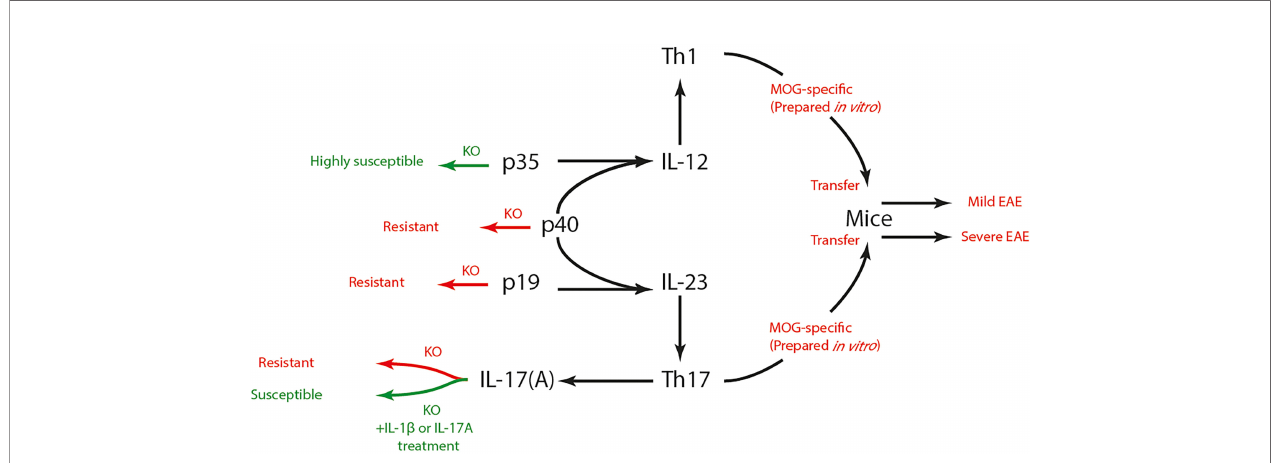
FIGURE 2 | Th1, Th17 cells and EAE susceptibility. IL-12 and IL-23 respectively promotes the differentiation of Th1 and Th17 cells. IL-12 is composed of p35 and p40 subunit, while IL-23 is composed of p19 and p40 subunit. Knock-out of p40 or p19 induced resistance to EAE in mice, yet p35 -/- mice showed high susceptibility to EAE. IL-17 is the signature cytokine secreted by Th17 cells. IL-17-di fi cient mice also showed resistance to EAE, which could be reversed by IL-1 b or IL-17 treatment. Both MOG-speci fi c Th1 and Th17 cells could induce EAE after being transferred to mice, yet their severities differ. Th, T helper; EAE, experimental autoimmune encephalomyelitis; IL, interleukin; MOG, myelin oligodendrocyte glycoprotein; KO,